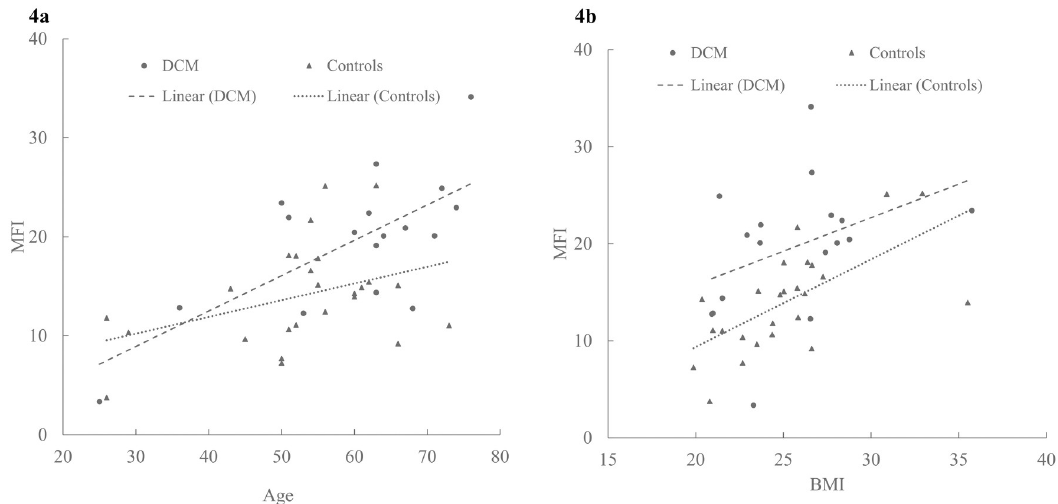
Fig 4. Association between MFI and demographic characteristics. Scatterplots depicting the relationship between a) MFI and age in patients with DCM and controls; b) MFI and BMI in patients with DCM and Controls. MFI = muscle fat infiltration, BMI = body mass index.